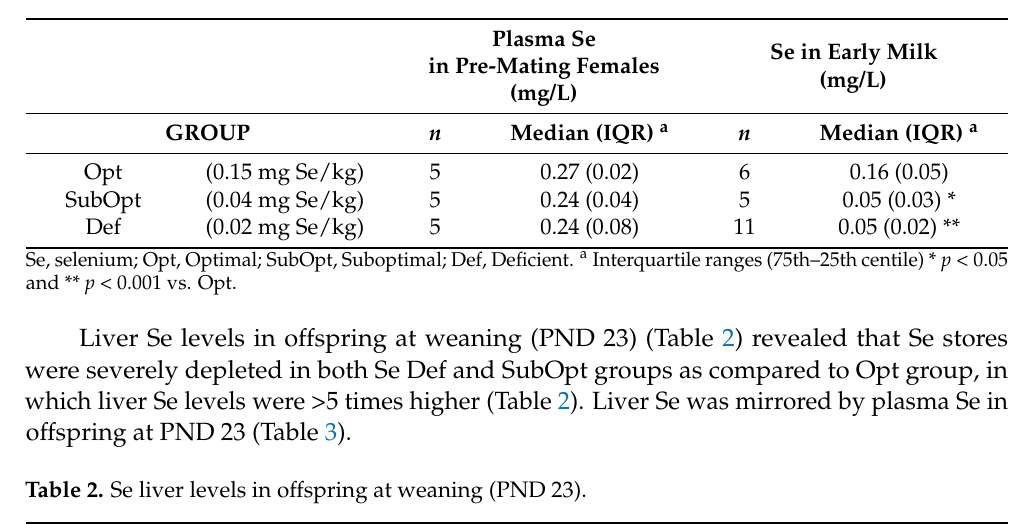
Table 1. Se levels in pre-mating female’s plasma and in early milk.